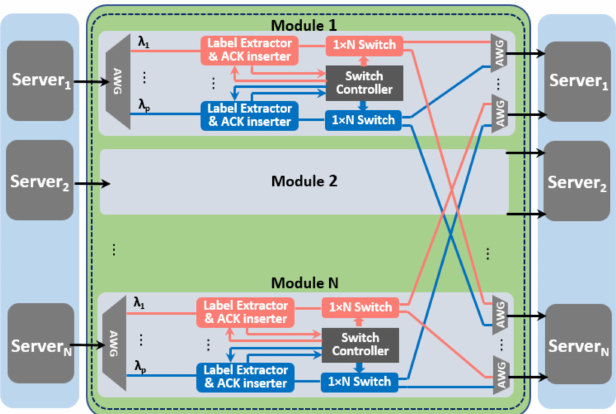
Figure 3. Schematics of Fast Optical Switches (FOS)